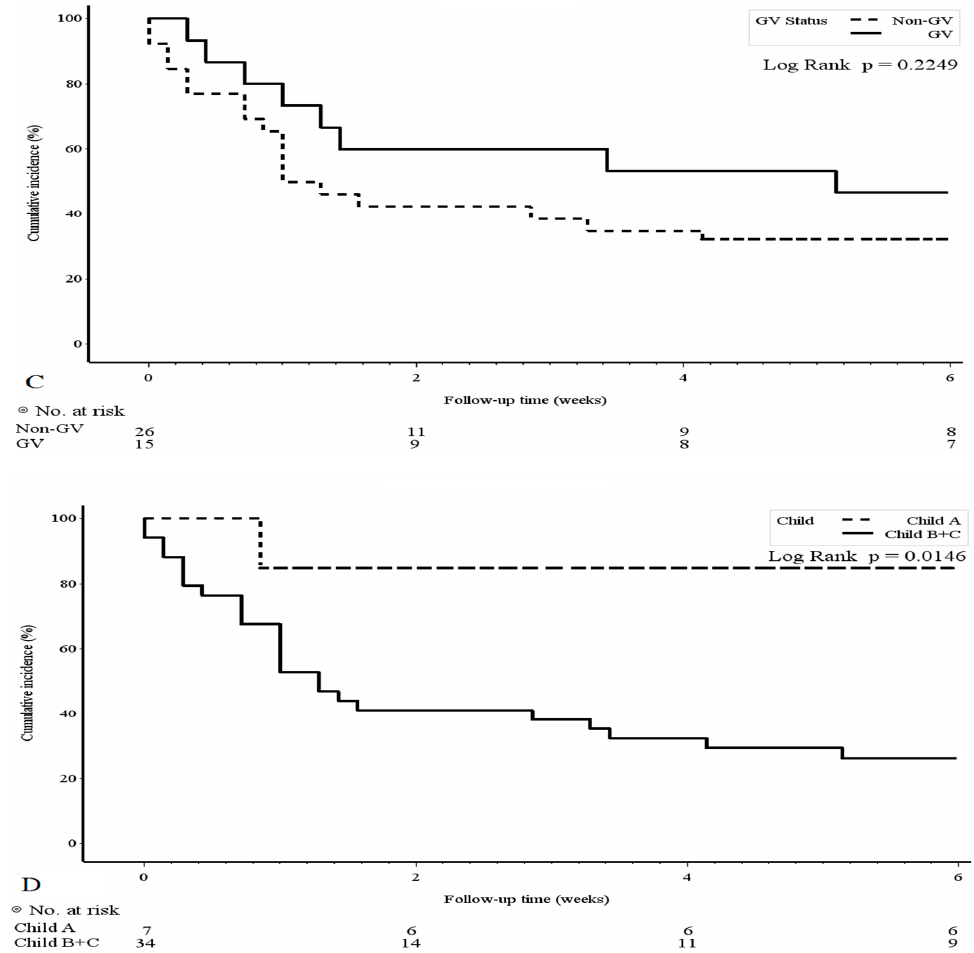
Figure 2. Kaplan-Meier estimates regarding the 6-week survival rate after post-banding ulcer bleeding stratified with ( A ) model for end-stage liver disease (MELD) score, ( B ) ALBI grade, ( C ) the presence of gastric varices and ( D ) Child-Pugh score.